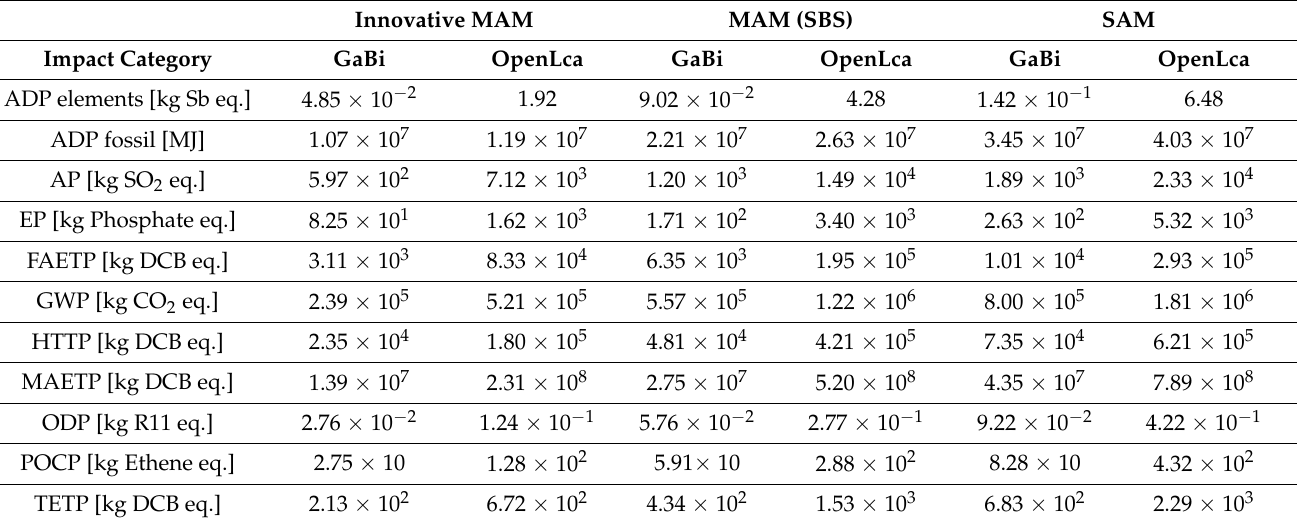
Table 7. Impact results for the three cases, Innovative MAM, MAM (SBS), SAM, with fixed thickness. Innovative